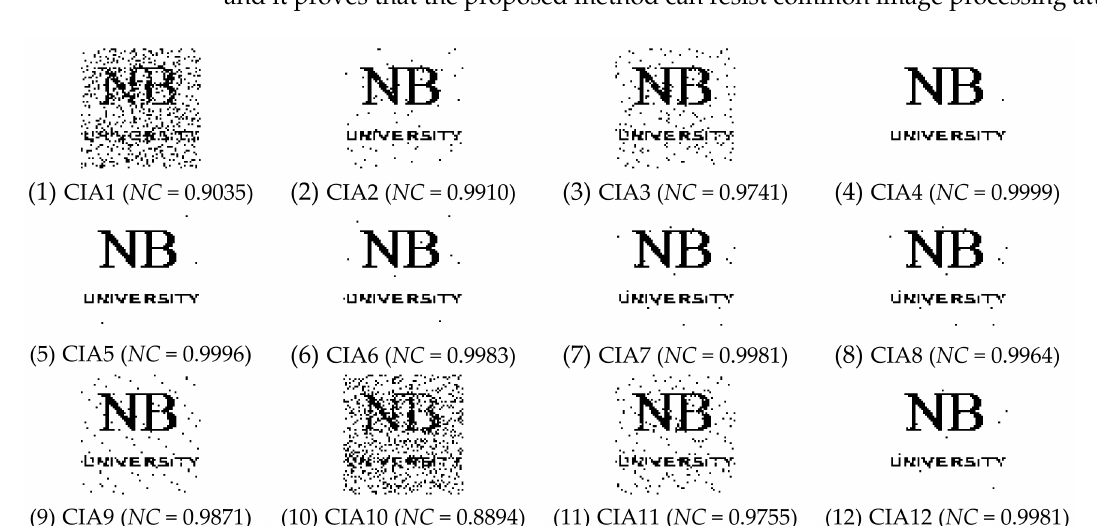
Figure 8. Extracted watermark from Rend01 under different image processing